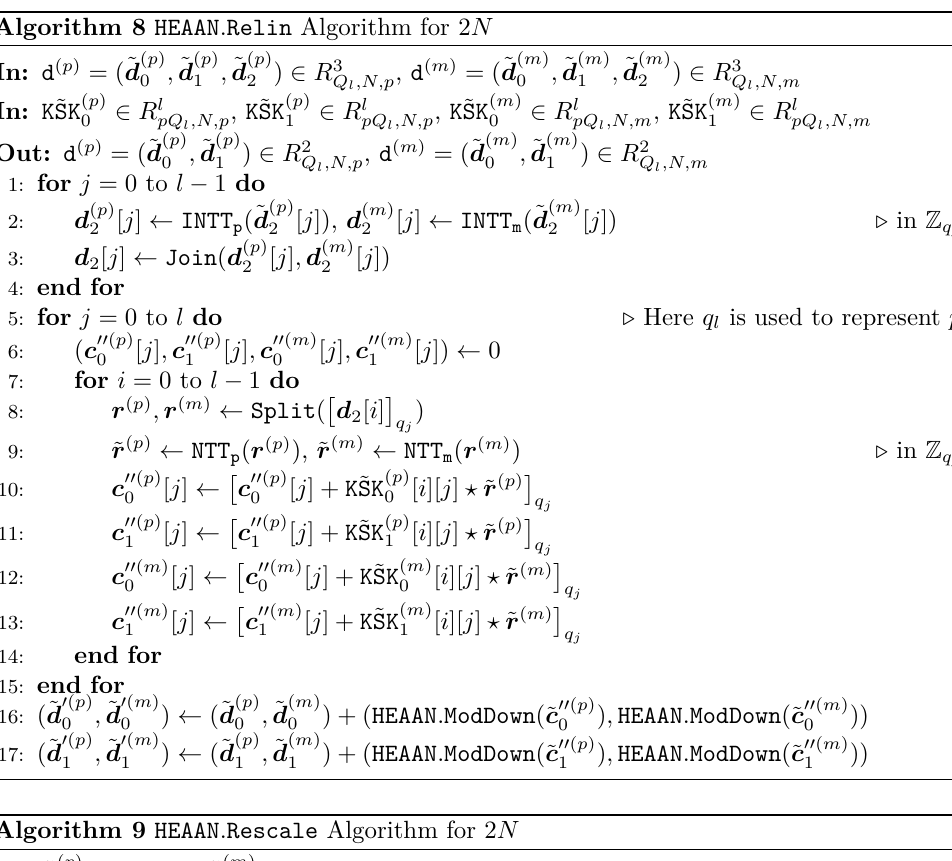
Algorithm 8 HEAAN . Relin Algorithm for 2 N